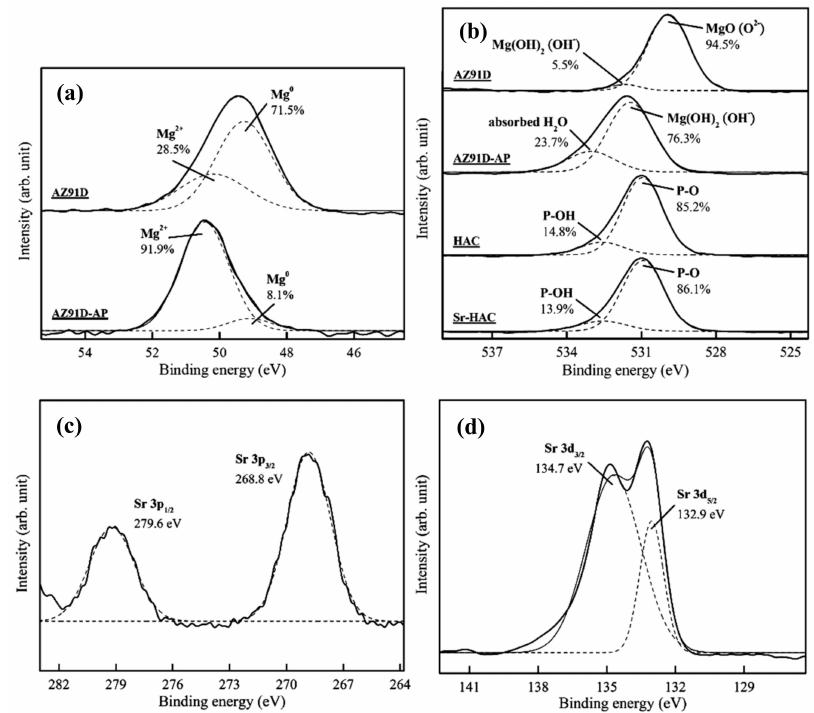
Figure 3. High-resolution XPS spectra of ( a ) Mg 2 p , ( b ) O 1 s , ( c ) Sr 3 p and ( d ) Sr 3 d bands for the Sr-HAC specimen with curve-fitting analysis